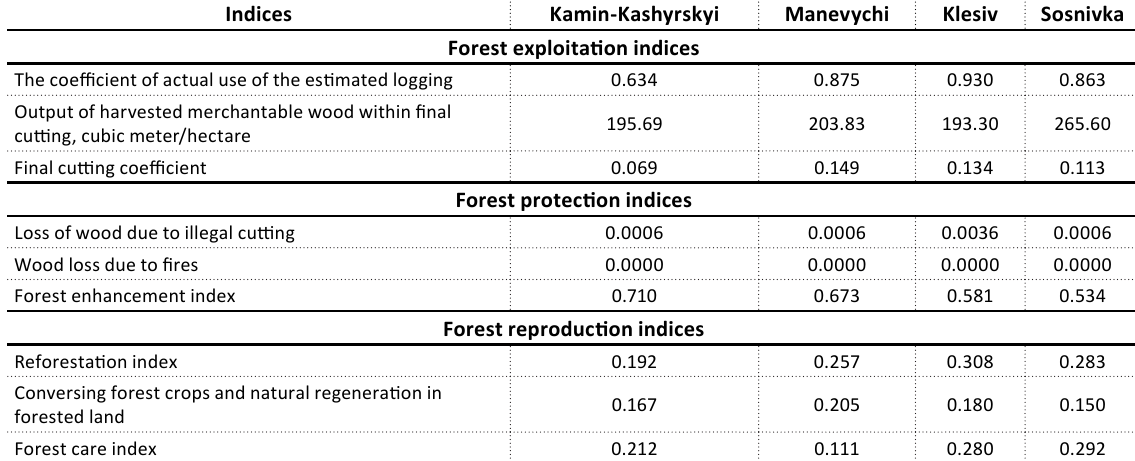
Source: A. Cherchyk’s calculations.